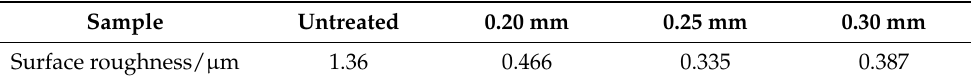
Figure 4. The structure of different preloading depths: ( a ) Untreated; ( b ) HT + UDR + 0.20 mm; ( c ) Table 5. Surface roughness of untreated and HT + UDR processed samples.